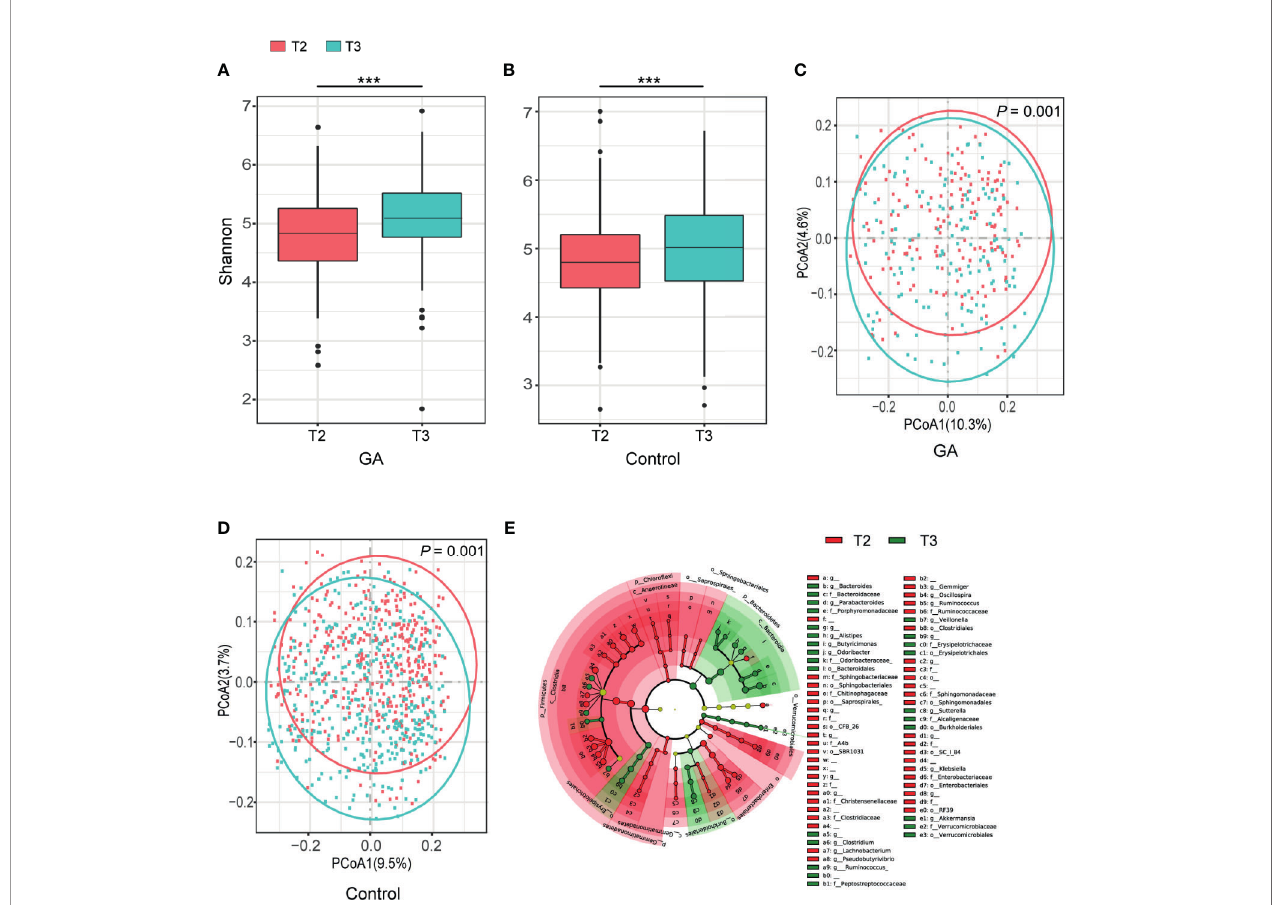
FIGURE 1 | Comparisons of alpha-diversity, beta-diversity, and variations of gut microbiota composition between T2 and T3. (A) Box plots based on Shannon diversity index in GA group. (B) Box plots based on Shannon diversity index in healthy control group. (C) PCoA based on unweighted UniFrac matrix of GA group. (D) PCoA based on unweighted UniFrac matrix of healthy control group. (E) The cladogram showed differently enriched taxa in the second trimester and the third trimester (FDR < 0.05). FDR, false discovery rate; PCoA, principal coordinate analysis; GA, gestational anemia; T2, the second trimester; T3, the third trimester; *** P <